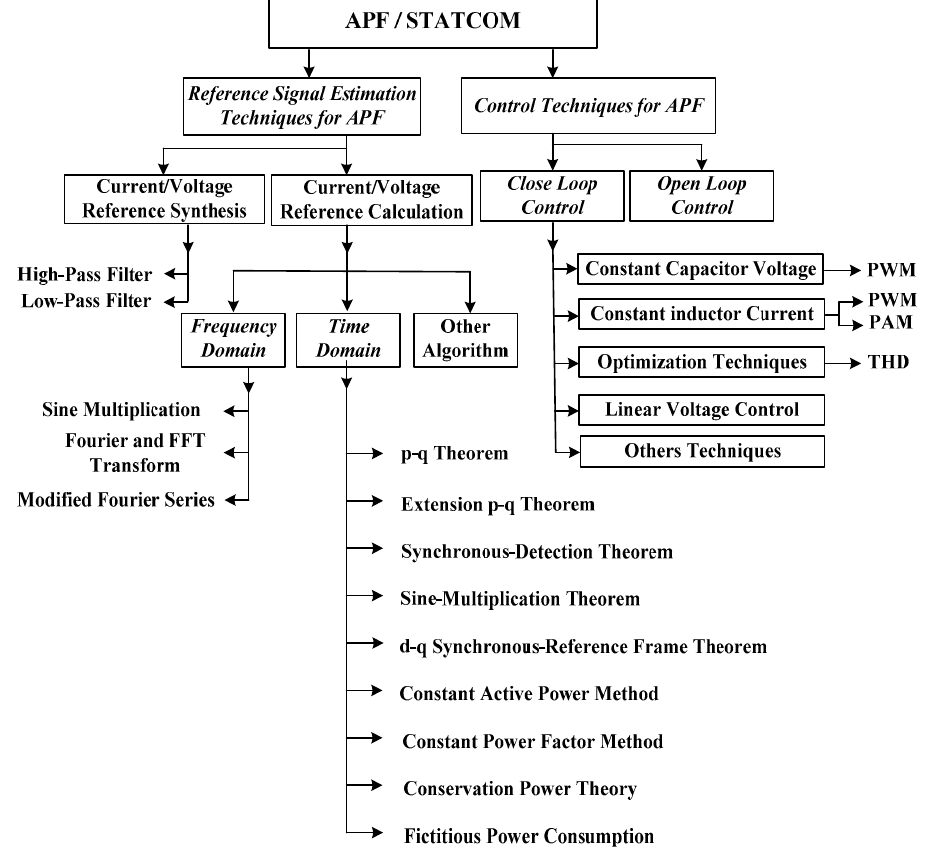
Figure 13. Different control techniques.